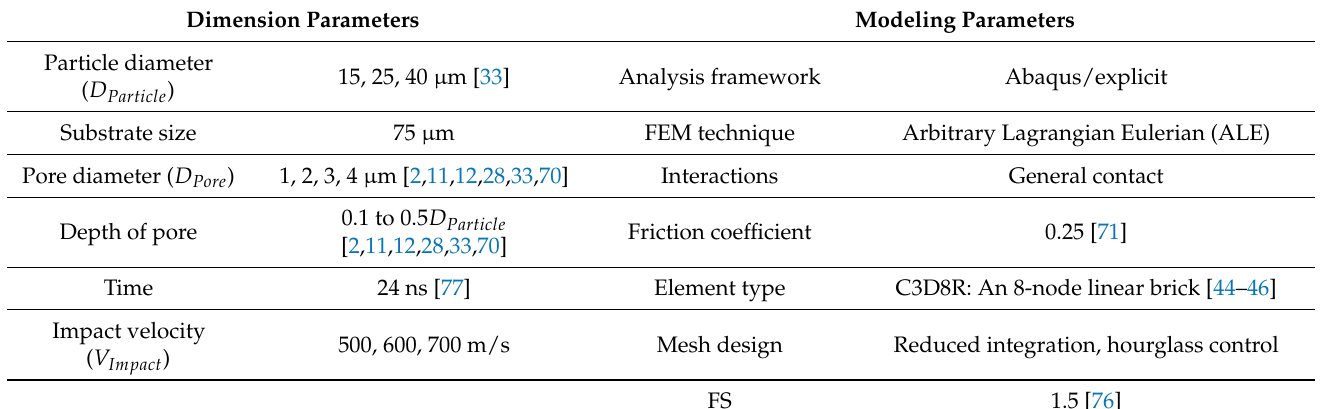
Table 3. The parameters used for numerical models of the impact deposition simulations in the Abaqus